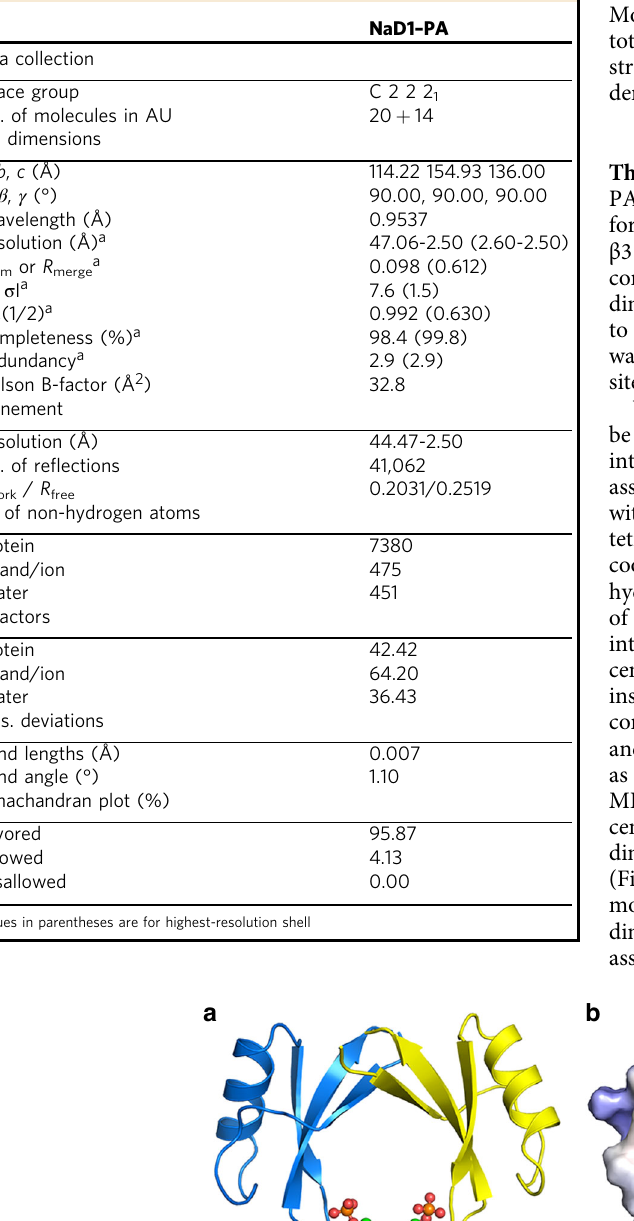
Table 1 Data collection and re fi nement statistics